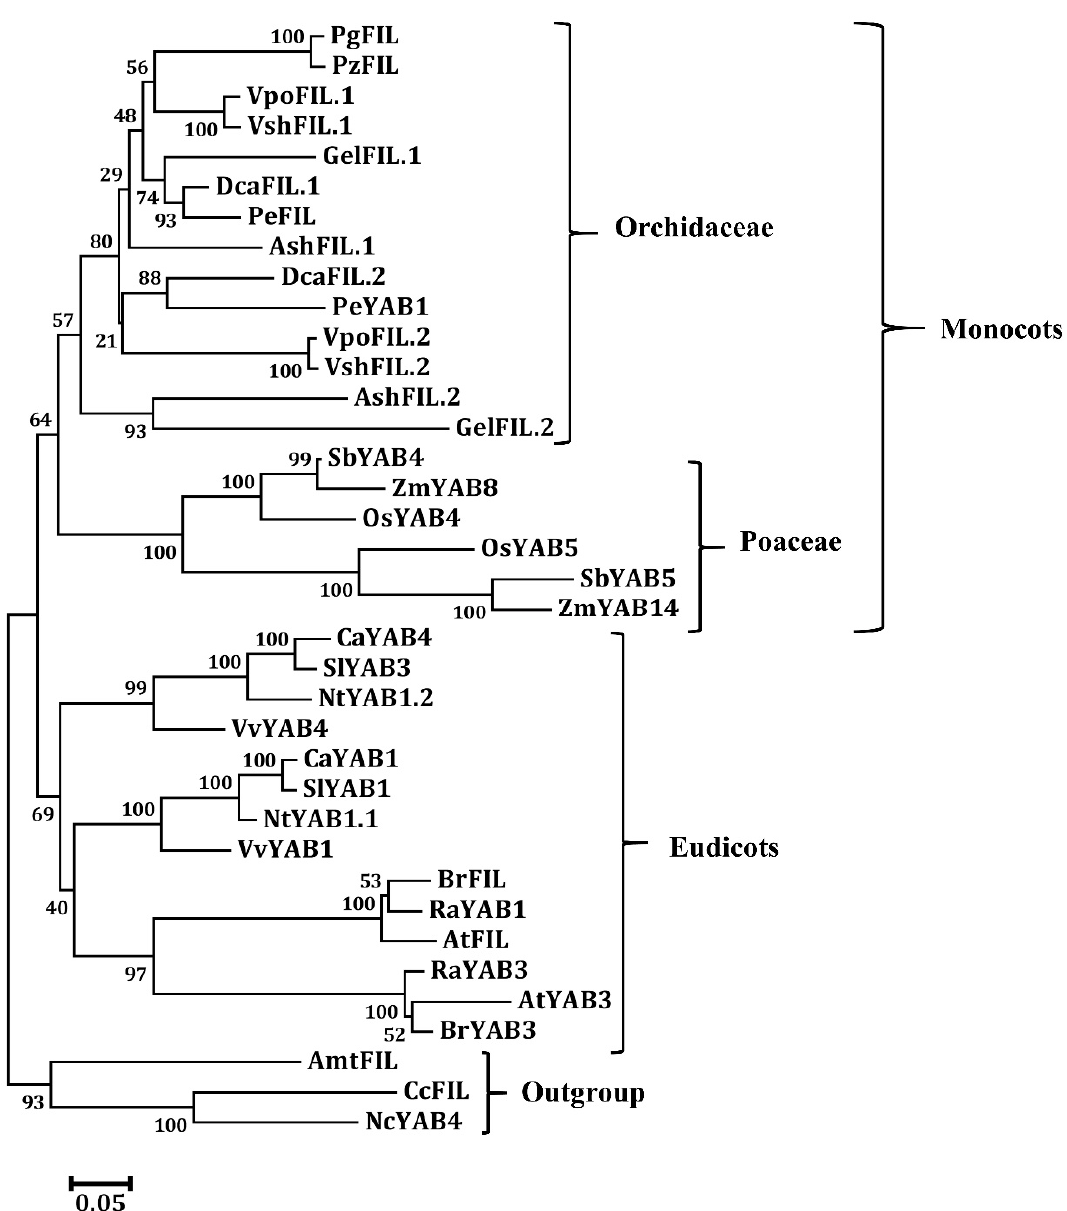
Figure 7. Phylogenetic tree of the FIL protein from the angiosperms. The phylogenetic tree was constructed with the neighbor-joining (NJ) method in MEGA 6.0 software. A bootstrap analysis was conducted with 1000 replications. The protein accession numbers for the related proteins are listed in Supplementary Table S1.